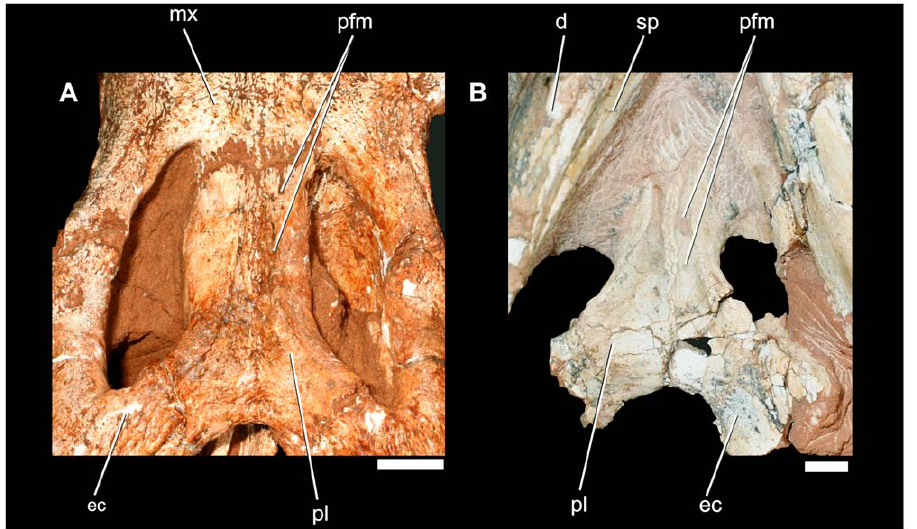
Figure 11. Details of the palatine ventral surface of Pissarrachampsasera . A) LPRP/USP 0019; B) LPRP/USP 0018. Scale bar equals 1 cm.